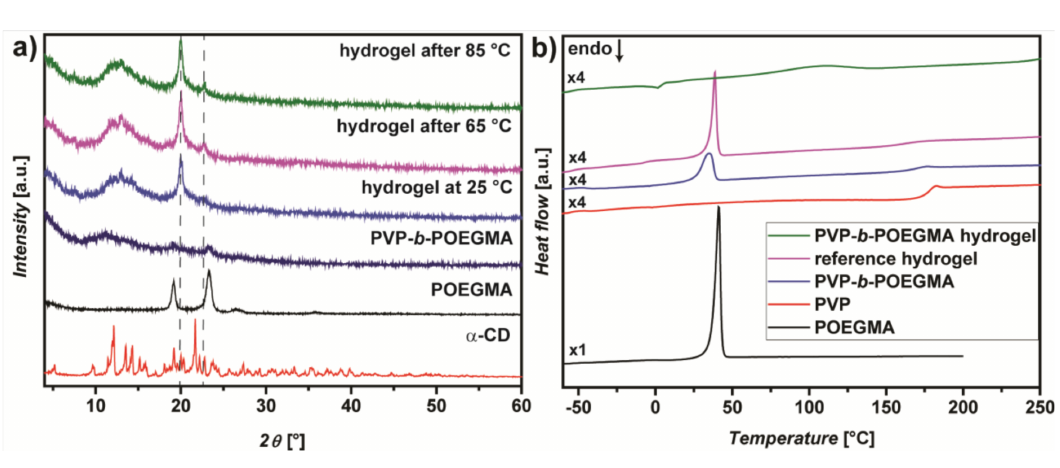
Figure 5. Microscopic characterization of hydrogels: ( a ) X-ray diffraction (XRD) patterns of